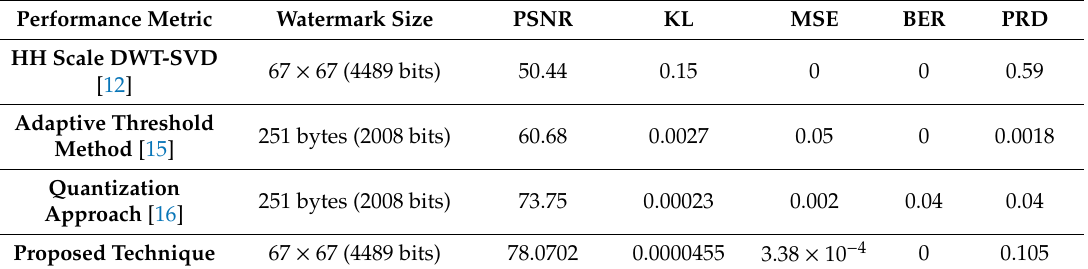
Table 5. Comparison of proposed technique with existing ECG